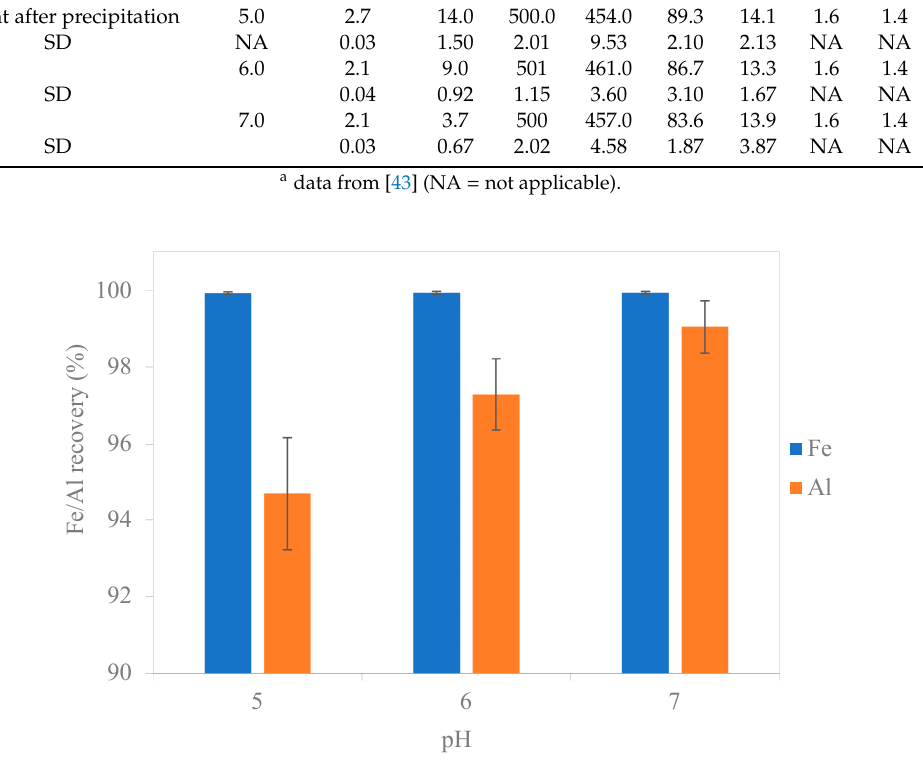
Figure 2. Effect of pH on Fe and Al recovery through precipitation of the AMD using NaOH and H 2 SO 4 25 °C . Metals 2019 , 9 , x FOR PEER REVIEW